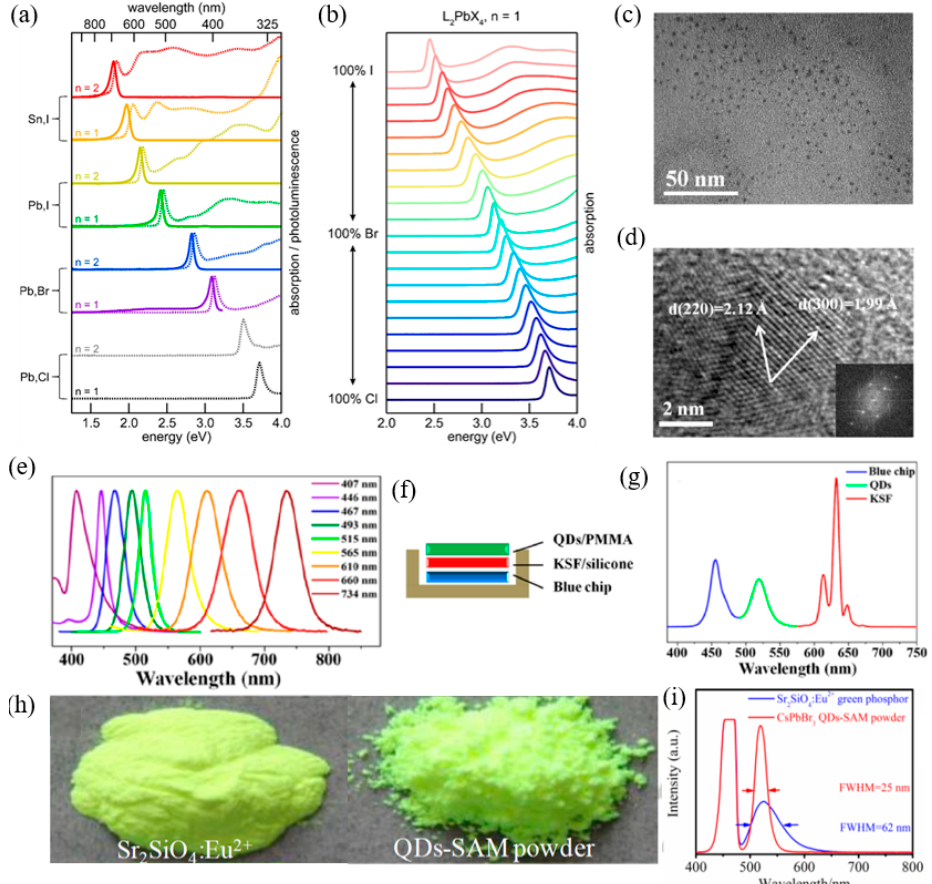
Figure 12. ( a ) When n = 1, n = 2 nanoplatelets were absorbed by solution phase and photolumines- cence spectra. ( b ) The emission spectrum of 2D perovskite nanomaterials when n = 1 [273]. ( c ) TEM image of colloidal CH 3 NH 3 PbBr 3 QDs. ( d ) The size distribution diagram of samples in figure ( a ). ( e ) PL emission spectra of CH 3 NH 3 PbBr 3 QDs. ( f ) Schematic diagram and ( g ) EL spectra of pc-WLED devices based on green emissive CH 3 NH 3 PbBr 3 QDs and red emissive rare-earth phosphor KSF [274]. Copyright 2015 American Chemical Society. ( h ) Optical images and ( i ) PL spectra of Sr 2 SiO 4 :Eu 2+ green phosphor and CsPbBr 3 QDs-SAM powder [275].